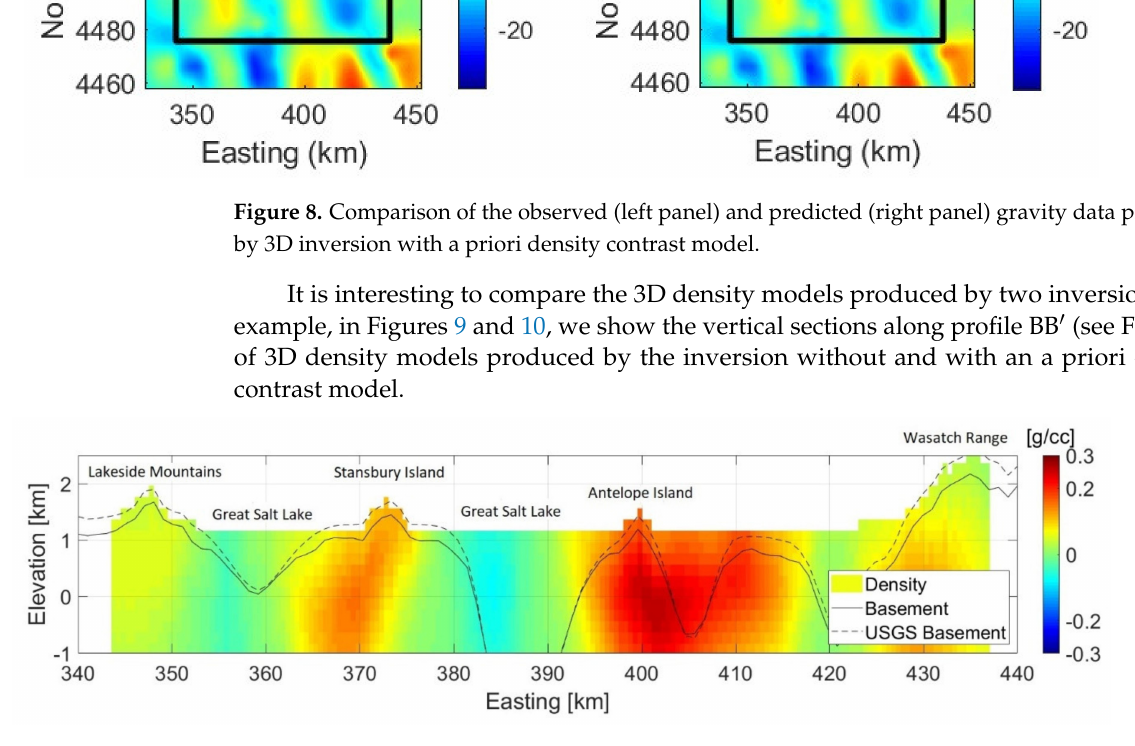
Figure 9. Vertical section along profile BB (cid:48) of 3D density model produced by the inversion without a priori